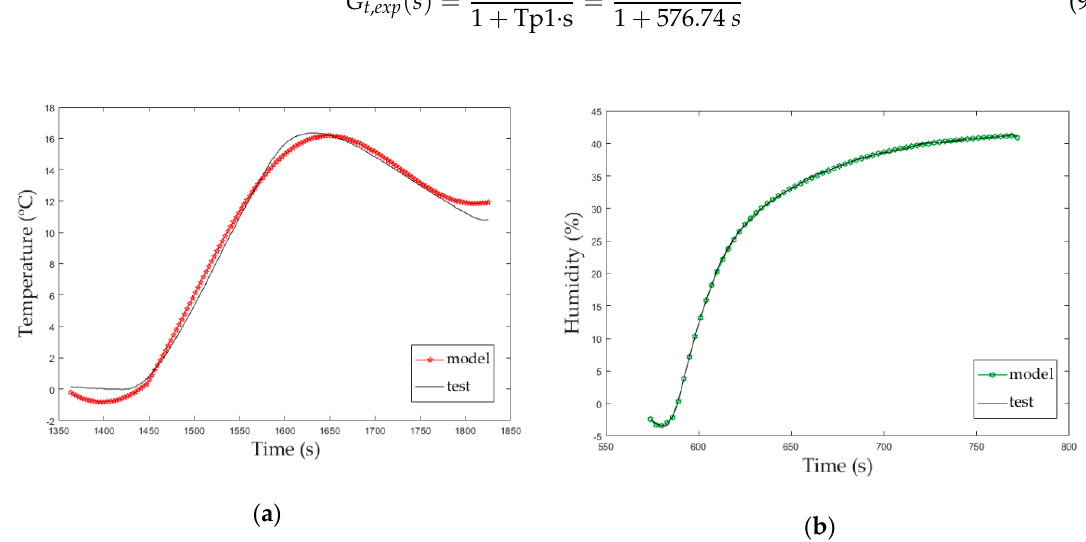
Figure 5. ( a ) Single input, single output (SISO) temperature study; ( b ) SISO humidity